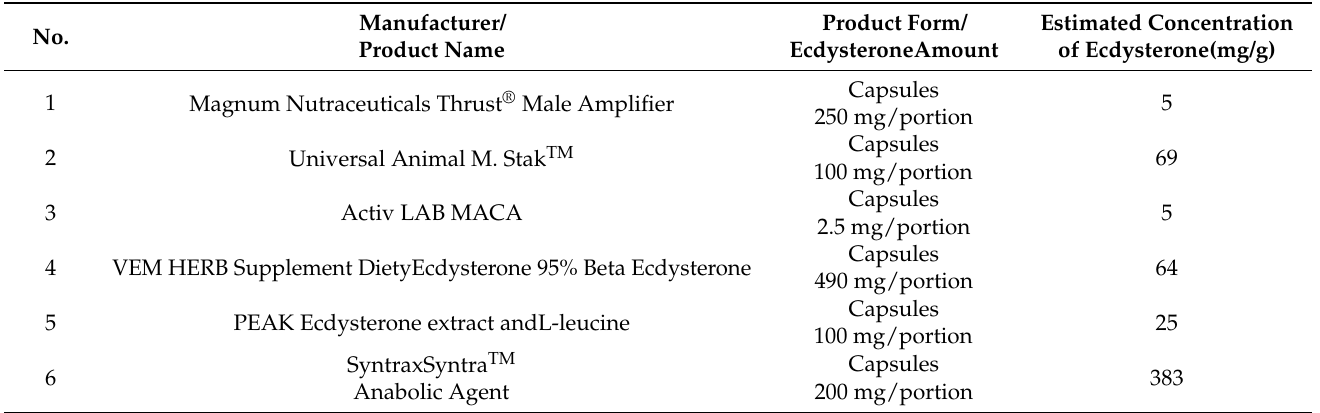
Table 1. Estimated concentrations of ecdysterone in the investigated dietary